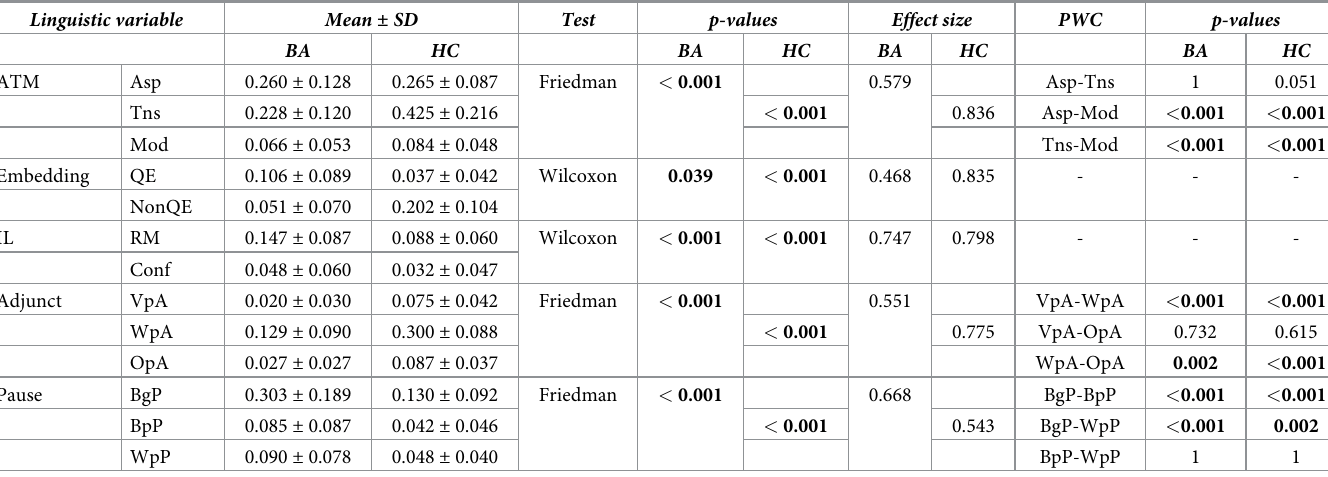
Table 3. Statistical significance for clinical and control groups in different subtypes of